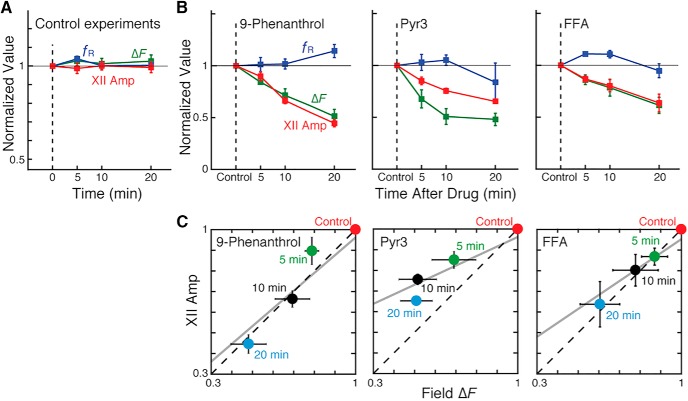
Time-dependent changes in the amplitude of integrated XII inspiratory burst activities (XII Amp) and the field GCaMP6f fluorescence transients (ΔF) of the pre-BötC glutamatergic population after TRPM4, TRPC3, and ICAN inhibitors. A, Control experiments (n = 5 mice) to test for possible photobleaching and time-dependent changes in population activity, in which calcium imaging was performed without any drug application with exactly the same protocol of image acquisition as the pharmacological experiments. The results (mean normalized values ± SEM) show that there were no significant changes in the pre-BötC field ΔF amplitude, XII Amp (normalized to control values), and normalized inspiratory burst frequency (fR). B, Group summary data (mean normalized values ± SEM) for 9-phenanthrol, Pyr3, and FFA (n = 5, 5, and 4, respectively) shows reduction in both XII Amp and the pre-BötC field ΔF amplitude, while fR changed nonsignificantly after applying channel inhibitors in all cases. C, Time-dependent reductions of XII Amp and field ΔF amplitudes after drug application were positively correlated (solid lines: linear regression; Pearson linear correlation coefficient for 9-phenanthrol, Pyr3, and FFA: r = 0.864, 0.845, and 0.749, respectively). The linear regression on mean amplitude reduction between XII Amp and field ΔF for 9-phenanthrol, Pyr3, and FFA yielded corresponding linear models with slopes m = 0.859, 0.463, and 0.676, and intercepts b = 0.103, 0.499, and 0.277, respectively. Dashed lines represent the identity line.